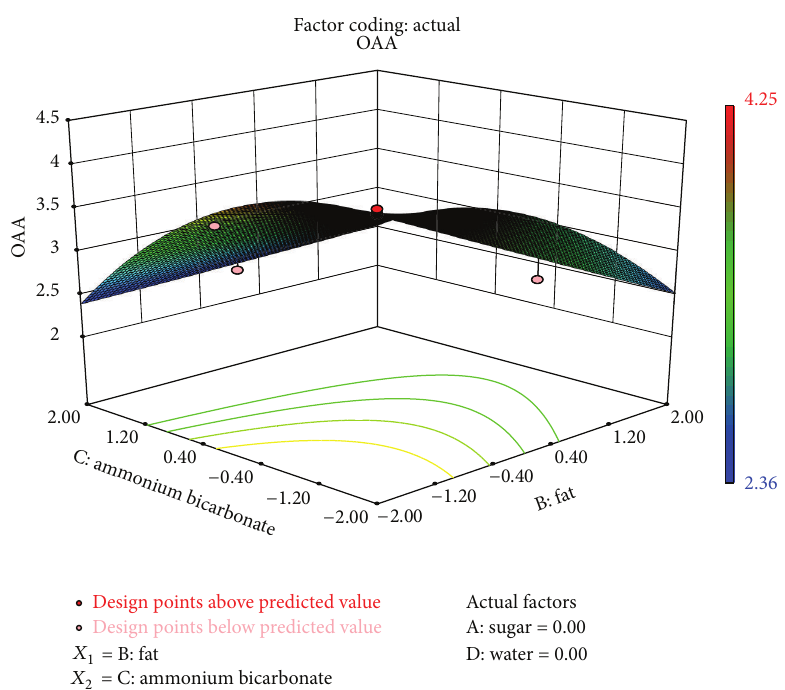
Figure 6: Surface plot representing the effect of fat ( 𝑋 2 ) and ammonium bicarbonate ( 𝑋 3 ) on overall acceptability of the